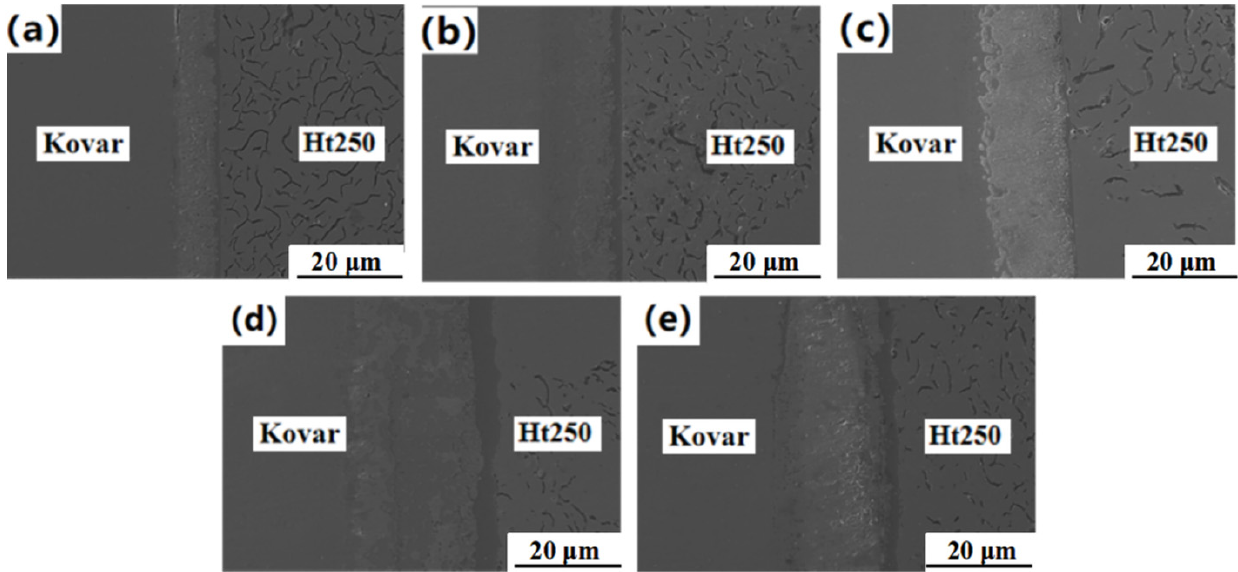
Figure 8. The microstructure of Kovar/Cu/Ti/Ht250 joints at ( a ) 940 °C, ( b ) 970 °C, ( c ) 1000 °C, ( d ) 1030 °C and ( e ) 1060 °C.